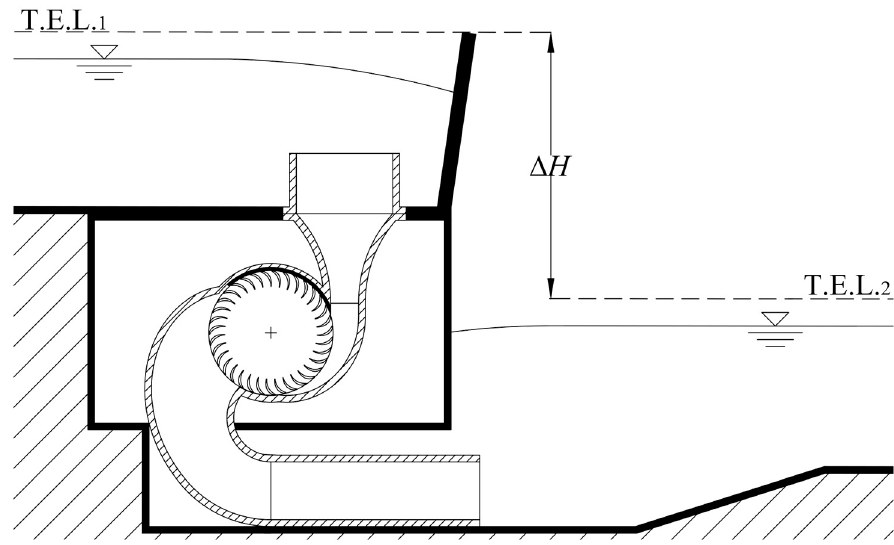
Figure 4. Section view of the UL-PRS turbine in a symmetry plan: T.E.L. is the total energy level and Δ H is the gross available hydraulic jump.